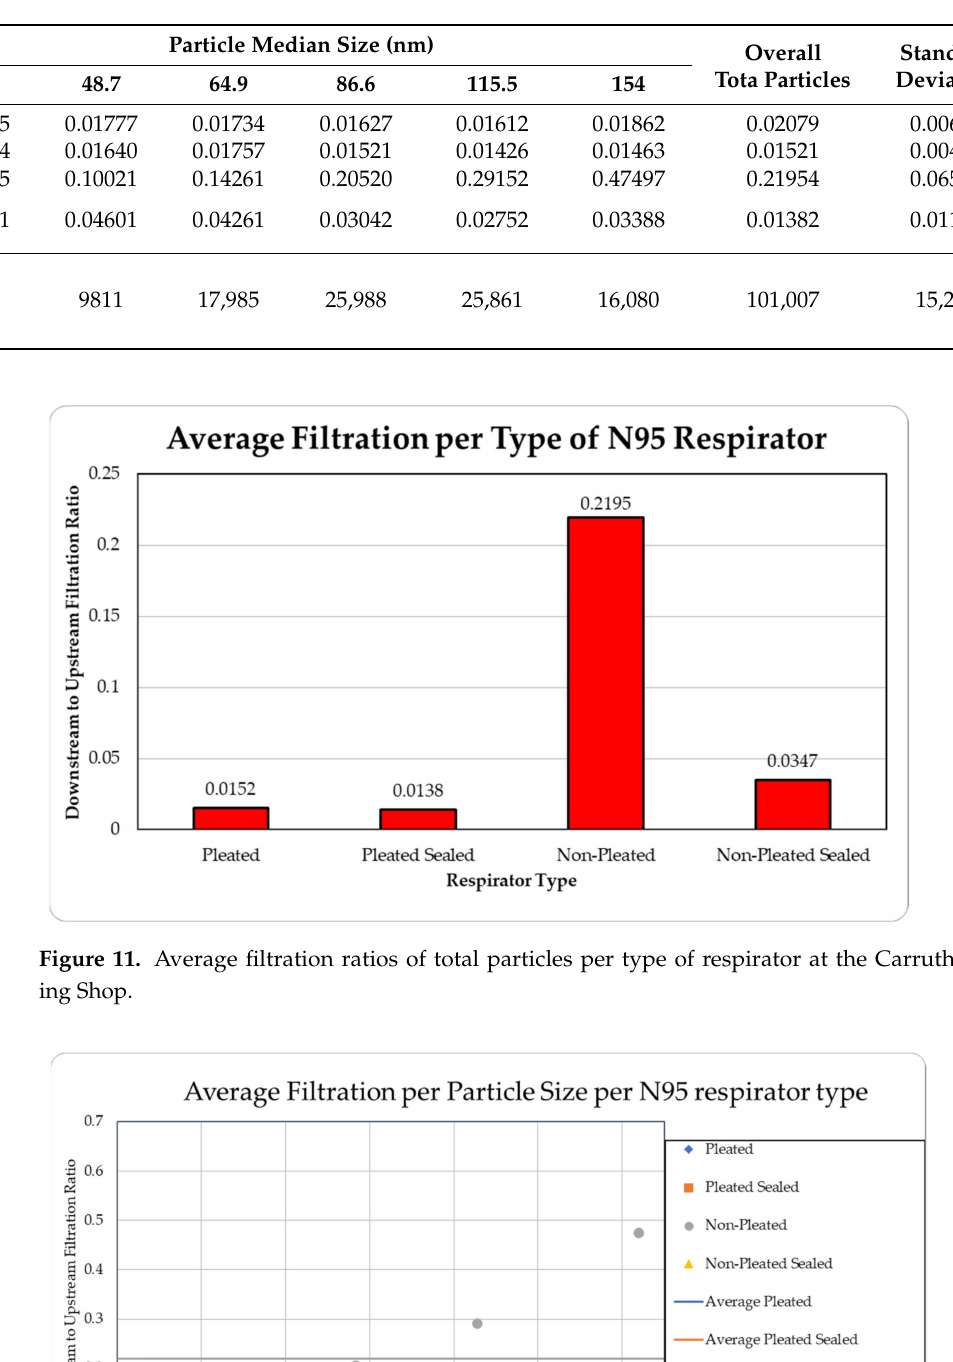
Table 4. Results of average downstream to upstream filtration ratios per type, particle size, and per respirator type at the Carruth Welding Shop.